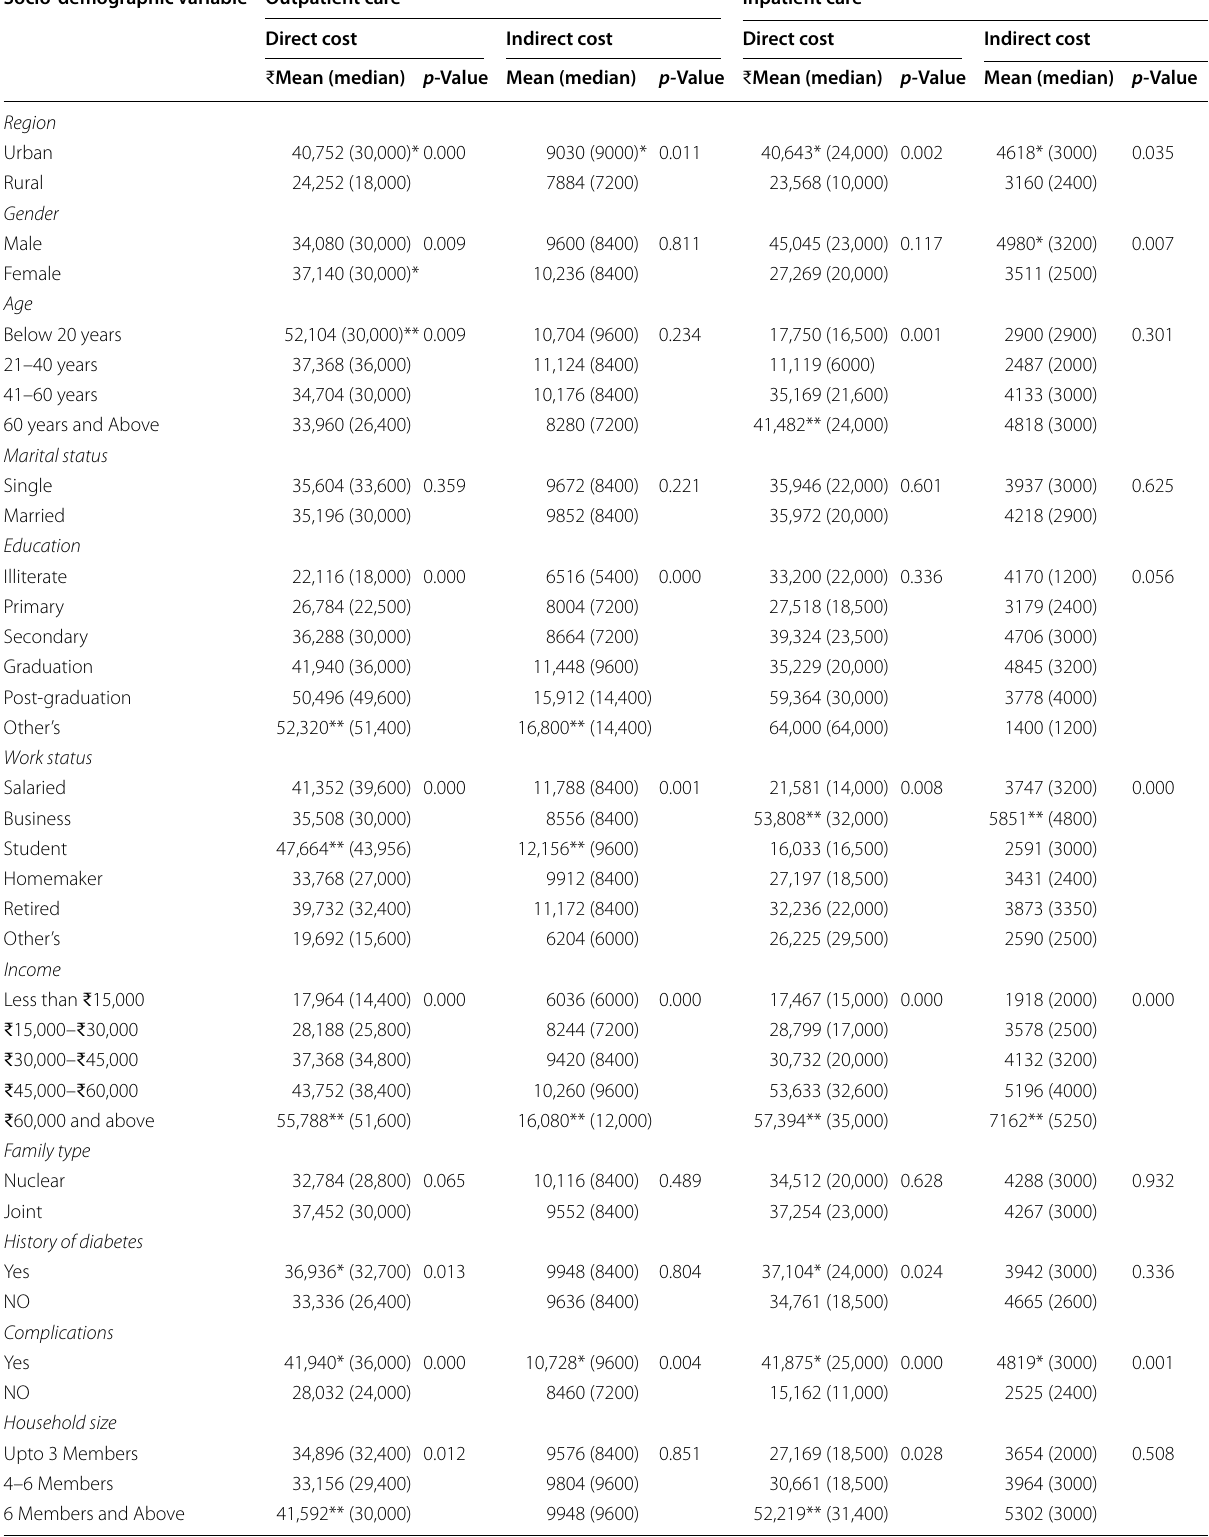
Table 2 Annual direct and indirect cost by socio-demographic characteristics of the patients utilizing outpatient and inpatient care Socio-demographic variable Outpatient